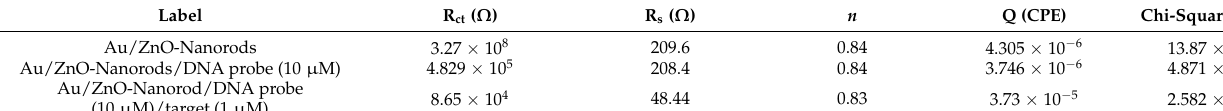
Table 2. Curve fit values for the Randles circuit of the impedance measurements.